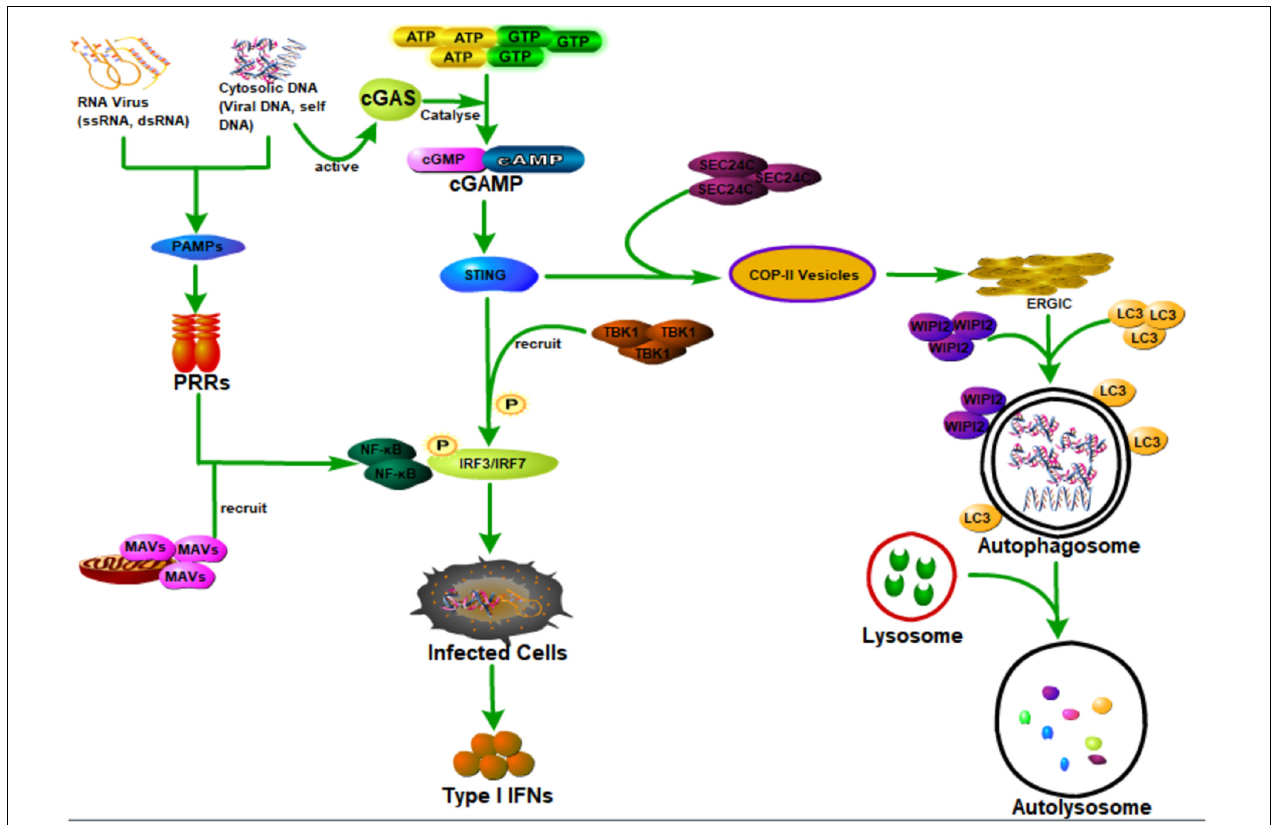
FIGURE 3 | Host autophagy defense against viral infection by promoting interferon production through activating innate immune response. Cyclic GMP-AMP synthase (cGAS) can be activated when it is bound to the cytosolic DNA (microbial or self-DNA), then the activated cGAS can catalyze GTP and ATP to be cyclic GMP-AMP (cGAMP), which can bind to and activate the stimulator of interferon genes (STING). The binding of cGAMP with STING, on the one hand, can lead to the interaction of STING with SEC24C, causing the budding of STING from the ER into the COP-II vesicles and forming the endoplasmic reticulum–Golgi intermediate compartment (ERGIC), which functions as the membrane source for WIPI2 recruitment and LC3 lipidation, and finally causing the formation of autophagosomes targeting cytosolic DNA or DNA viruses to the lysosome for degradation. On the other hand, it can also recruit and activate the tank-binding kinase 1 (TBK1) causing the phosphorylation of the transcription factor IRF3 to induce the production of type I interferons (IFNs). In addition, viral DNA, viral double-stranded RNA (dsRNA), viral single-stranded RNA (ssRNA), or viral surface glycoproteins, express the pathogen-associated molecular patterns (PAMPs), which can be specifically recognized by several classes of germline-encoded pattern-recognition receptors (PRRs) of the host cells. Moreover, PRR could activate IRF3/IRF7 and NF- κ B transcription factors by recruiting mitochondrial antiviral signaling protein (MAVS), leading to the activation of type I IFN responses and establishment of an antiviral state.